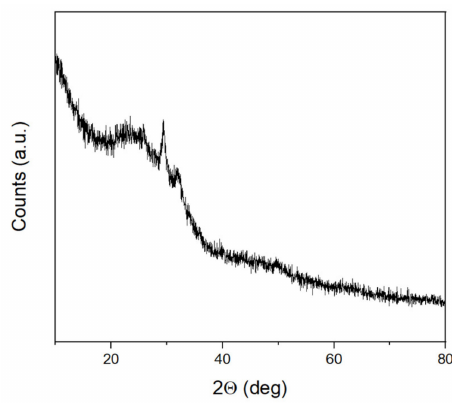
Figure 1. X-ray diffraction pattern of the obtained BGl@PcHfCl 2 .